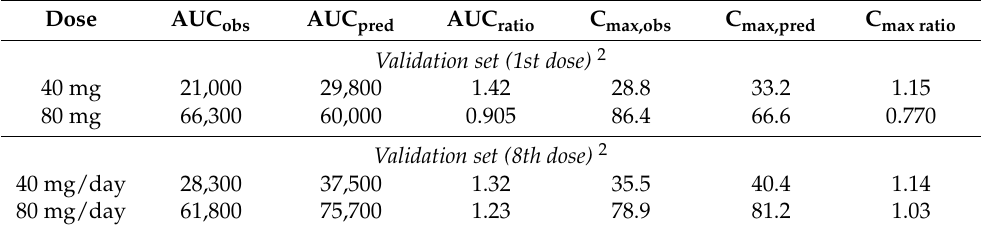
(A) (B) Figure 4. Observed and simulated fexuprazan time-concentration profiles at first doses of 40 mg (A) and 80 mg (B) in Korean, Caucasian, and Japanese populations. Solid lines represent results of optimized simulation or model fitting. Closed circles (●) represent observed data [1,23] . Data are as means ± SD for 24 volunteers including all Korean, Caucasian, and Japanese populations.